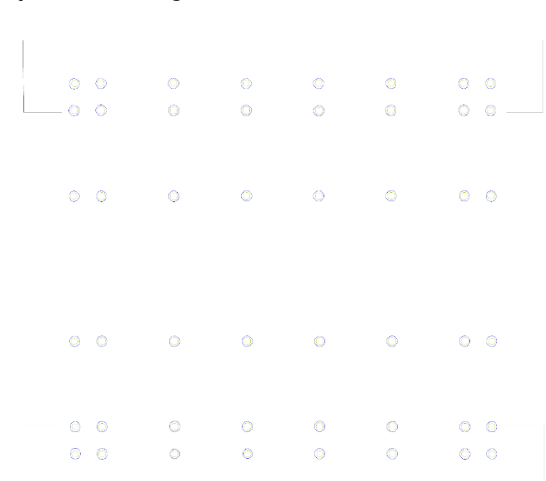
Figure 5. the actual grid system model of Jingfu Palace